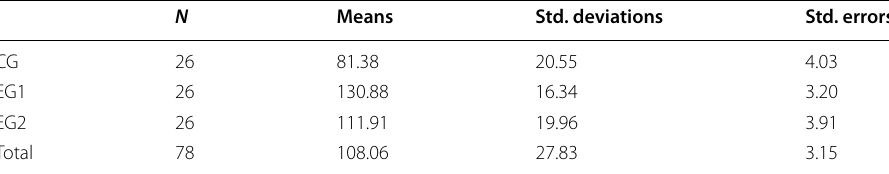
Table 9 Descriptive statistics: the participants’ post-tests of FLCA scores N Means Std. deviations Std. errors CG